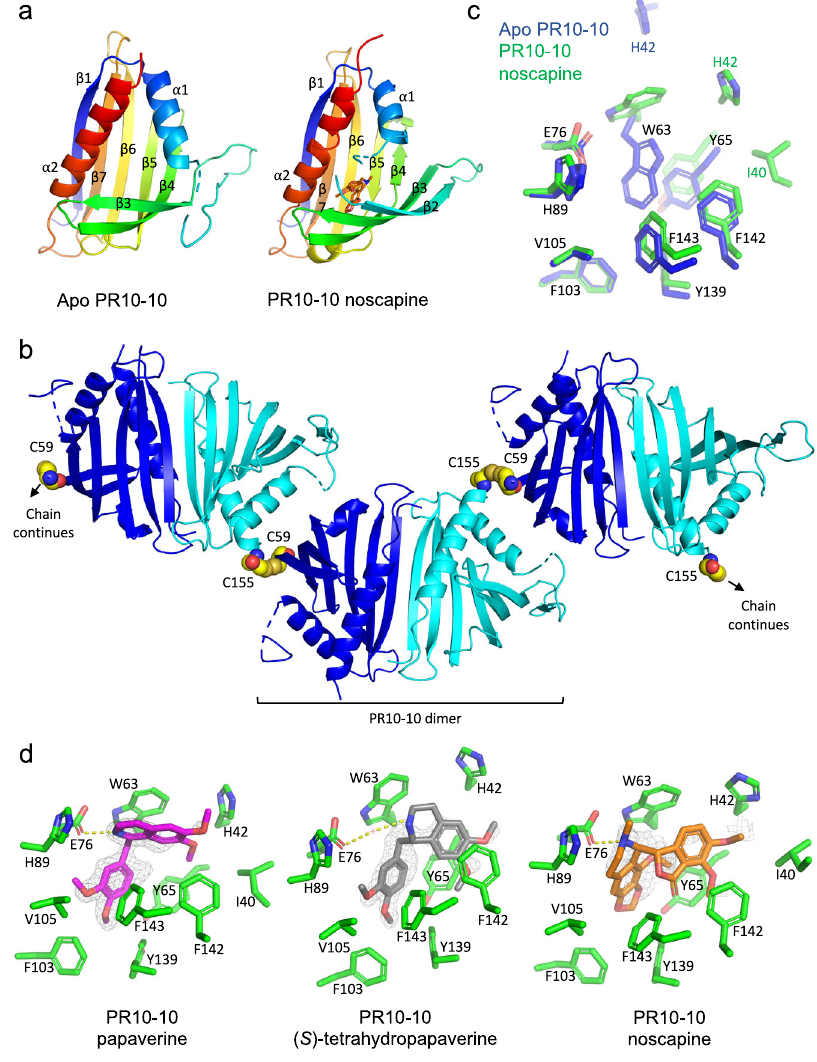
Fig. 5 | Crystalstructure Apo-PR10-10and PR10-10 incomplexwith noscapine, papaverine, and ( S )-tetrahydropapaverine. a Front view of single PR10-10 pro- tomers for the apo and noscapine complexed structures of PR10-10. The rainbow coloring scheme starts at the C-terminus in red to the N-terminus in blue. Helices and β strands are numbered accordingly. Noscapine is shown in orange. b Apo PR10-10 ‘ in-crystal ’ polymerandPR10-10dimer.ProtomersfromthePR10-10dimer areshownincyanandblue.Disul fi desareshownasyellowspheres. c comparisonof the apo and noscapine complexed PR10-10 binding pocket. Dark blue atoms and bonds correspond to apo PR10-10 carbons, green atoms and bonds to papaverine